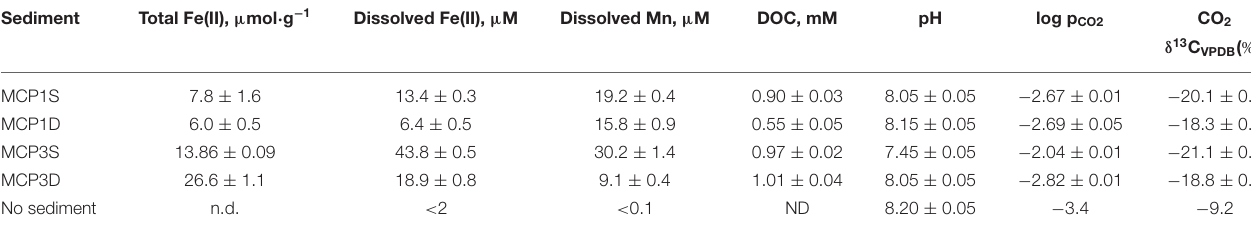
TABLE 5 | Concentrations of total Fe(II), dissolved Fe(II), dissolved Mn and DOC, and pH, p CO2 and δ 13 C values of CO 2 at incubation time = 57 day. Sediment